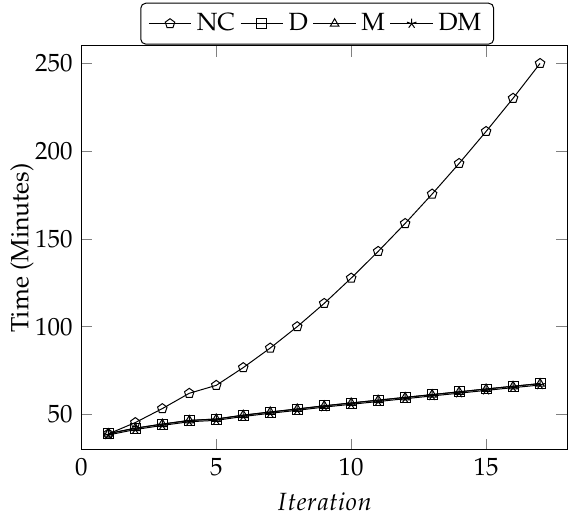
Figure 10. Performance of different cache management on iteration.